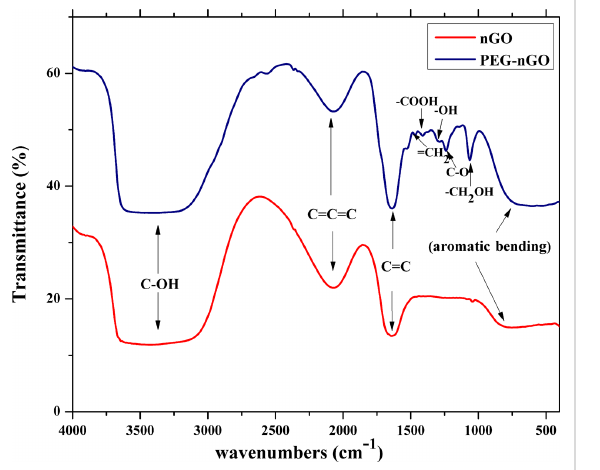
Figure 3: UV–vis spectra of nGO and PEG-nGO. The red-shift of the UV peak confirmed the nGO loading with PEG.